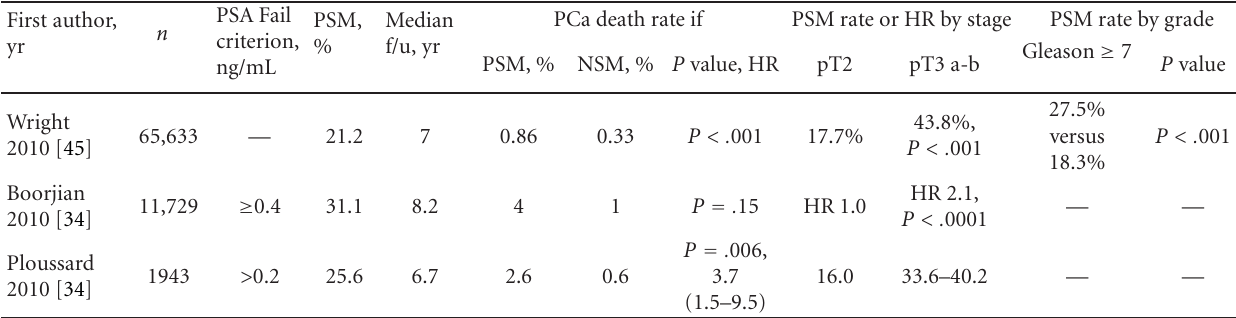
Table 6: Modification of prostate cancer mortality rates according to stage or grade, at 10